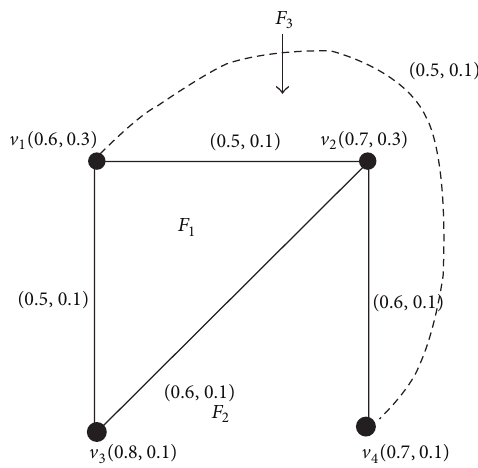
Figure 4: Faces in intuitionistic fuzzy planar